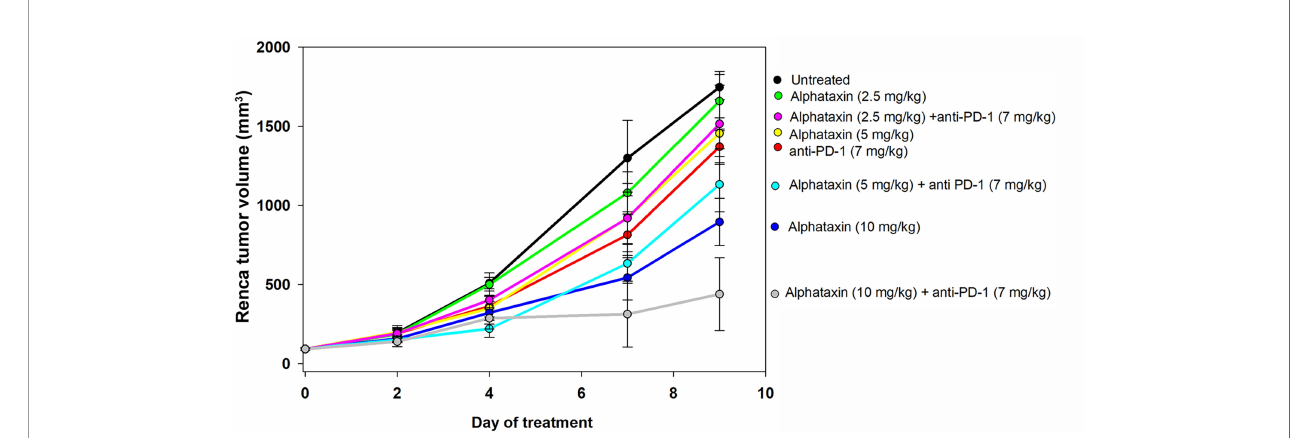
FIGURE 4 | Tumor Growth Curves of Subcutaneously Implanted Tumor Cells. Renca cells (2 x 10 5 ) were subcutaneously implanted into 8 female BALB/c mice per group and allowed to grow for 2 weeks before the mice remained untreated ( ● , n = 7) or were treated with an anti-PD-1 antibody ( , 7 mg/kg, n = 6) via IP injection twice per week or with Alphataxin via daily oral gavage at a dose of 2.5 mg/kg ( ● ), 5 mg/kg ( ), or 10 mg/kg ( ) (n = 8/arm). In combination treatment, mice were treated with anti-PD-1 (7mg/kg) via IP injection twice per week and with Alphataxin via daily oral gavage at a dose of 2.5 mg/kg ( ), 5 mg/kg ( ), or 10 mg/kg ( ) (n = 8/arm). Tumor volume was calculated periodically using calipers. Alphataxin (10 mg/kg) signi fi cantly suppressed tumor growth as compared with Alphataxin (5 mg/kg) or Alphataxin (2.5 mg/kg) (P < 0.001, n = 8/arm). Data were normalized to baseline tumor volume and are presented as the means and standard deviations.